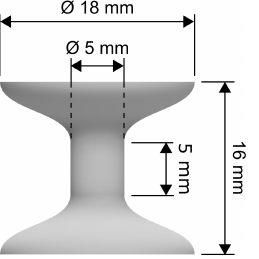
Figure 1. Visualisation of the specimen